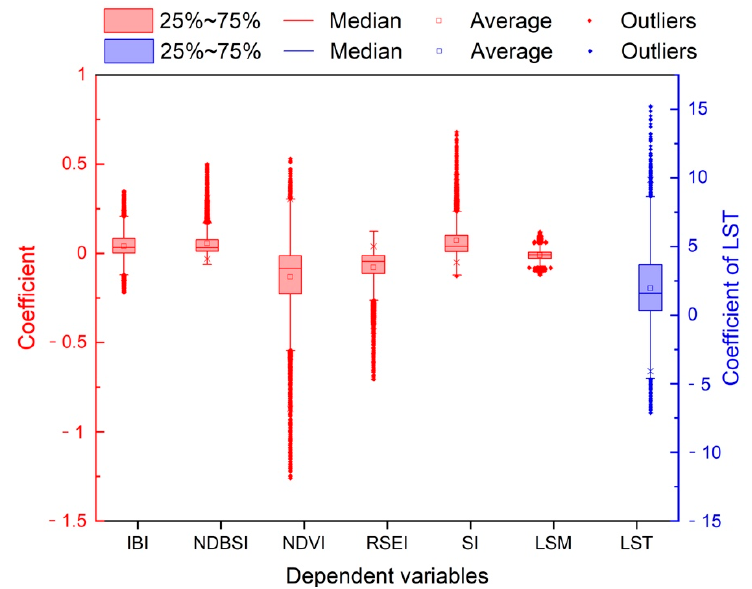
Figure 3. Boxplot of coefficient statistics of the geographically weighted regression (GWR) models.